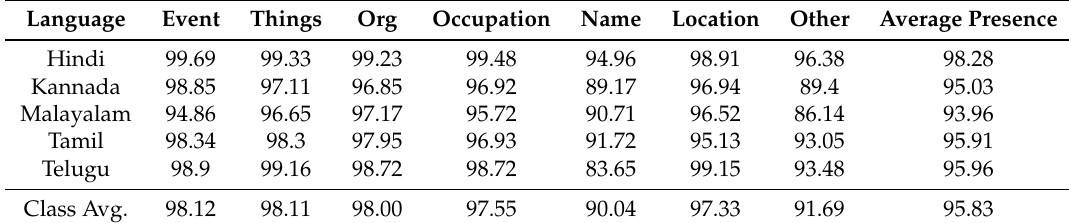
Table 2. Presence percentage of the training set entities in FastText word embedding